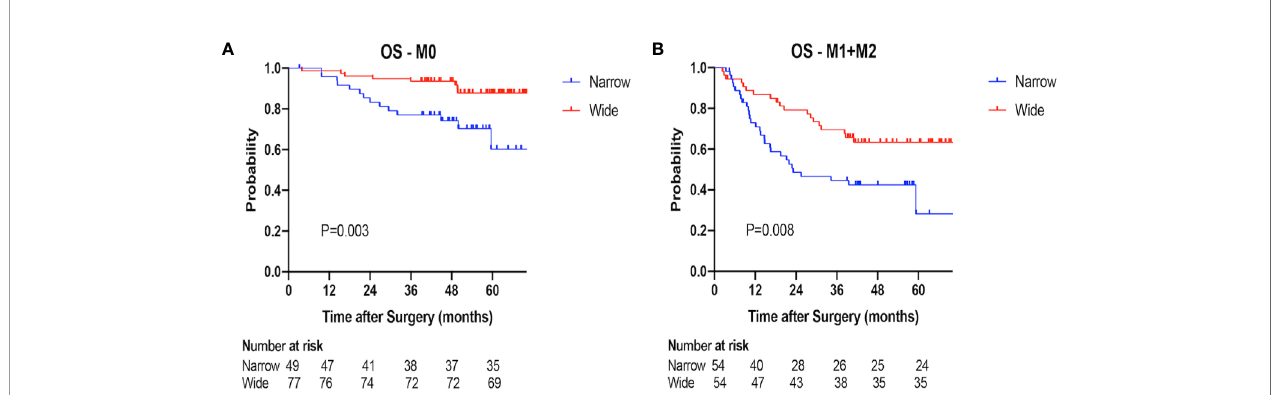
FIGURE 5 | Overall survival (OS) of the narrow-margin and wide-margin groups strati fi ed based on MVI status. (A) Overall survival in the subgroup of M0. (B) Overall survival in the subgroup of M1+M2.